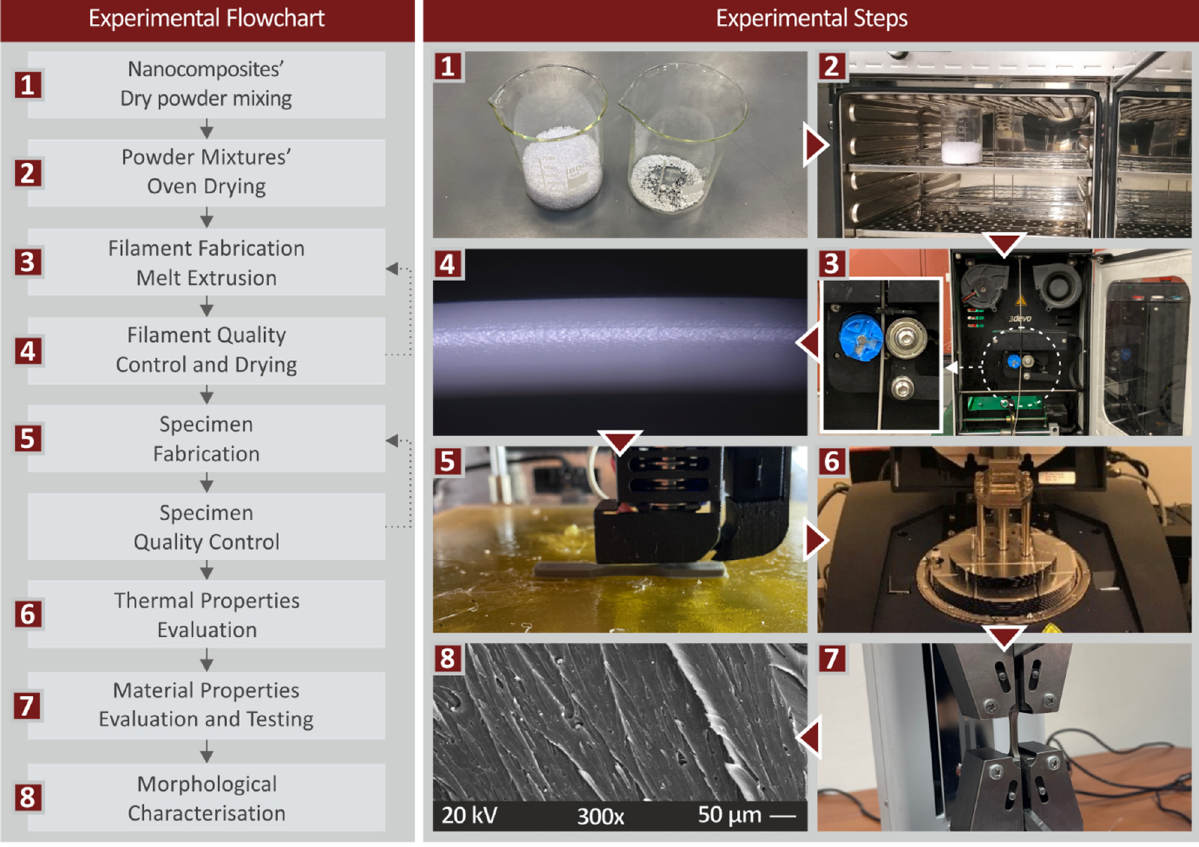
Figure 1. Steps of the experimental process.